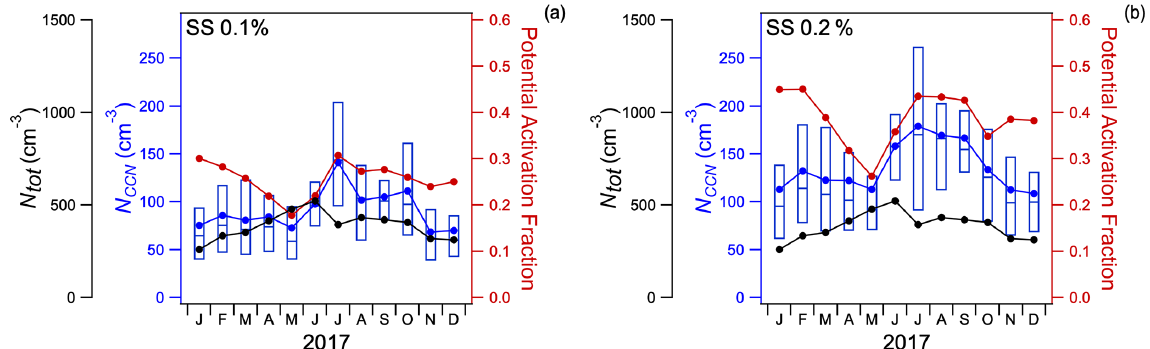
Figure 3. Box and whisker plot of N CCN , 0 . 1% (a) and N CCN , 0 . 2% (b) , mean N CCN is the blue circles, median -, box bottom at 25%, box top at 75%, whisker bottom at 10%, and whisker top at 90%, mean N tot is the black circles, and CCN potential activation fraction is the red circles. Table 2. Summary of multiday transported aerosol plumes events that affected the ENA in 2017 including duration, aerosol emission origins, and CALIPSO classification. The values of the three aerosol properties used by the algorithm to detect the events (median concentration of particles with D p 100–1000nm, median SSA 1µm at λ 464nm, and mean BC values) are shown in the rightmost column during each event (first line) and under baseline condition (in italic, second